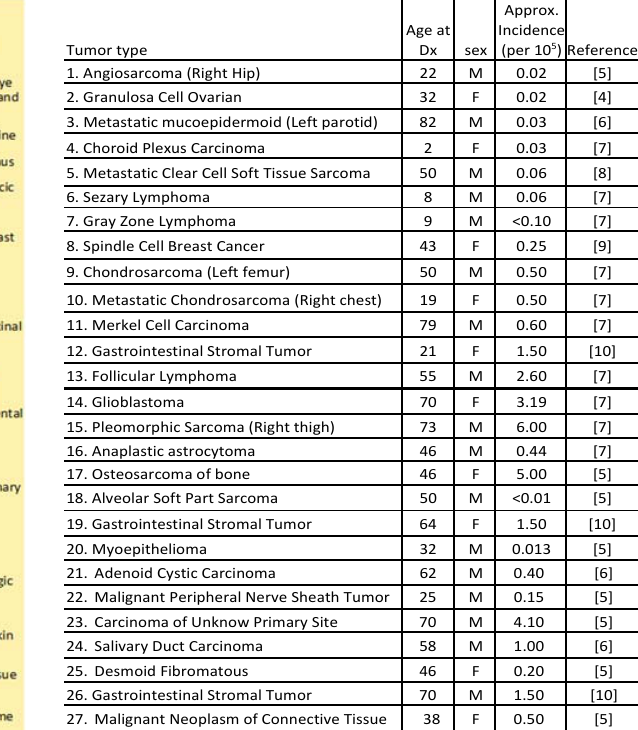
Figure 1. Approximate locations of rare tumors. Rare tumor types as numbered in Table 1 are shown in red dots with age at diagnosis, gender and incidence. Tumors of the blood or lymph are shown in one location labeled ‘heme’, while tumors of skin are shown in dashed box labeled ‘skin’ and tumors of soft tissue are shown in dashed filled box labeled ‘soft tissue’ (on left leg). Common cancer types used for comparisons are shown in lavender: Lung (L), Breast (B), Colon (C), and Prostate (P). Gray zone lymphoma (#7) – lymph node; GIST (#12) – Stomach; 13 Follicular lymphoma (#13) – lymph node; Primary mediastinal lymphoma (#19) – between the 2 lungs in the mediastinum [4,12–17].